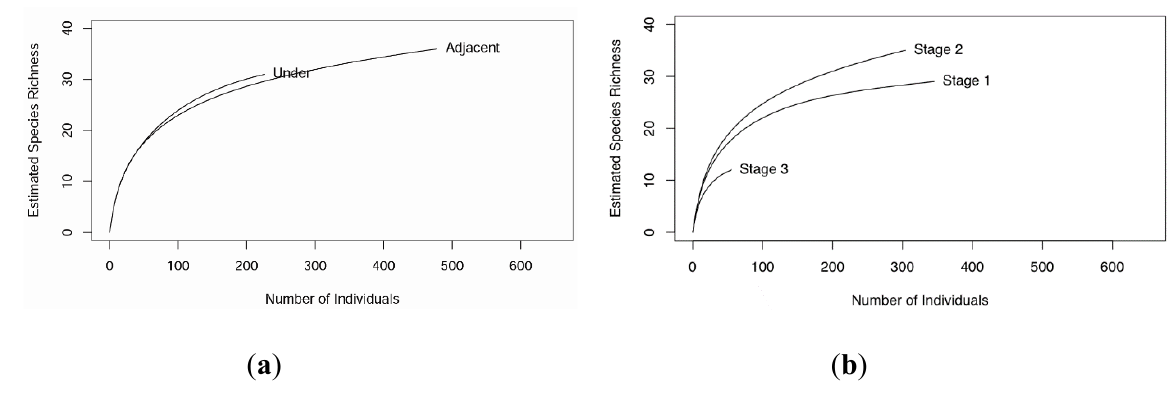
Figure 2. Rarefaction curves depicting estimated number of oribatid species per number of individuals sampled grouped among ( a ) both under and adjacent CWM positions and ( b ) among the three chronosequence stages (Stage 1: 60–95 years after fire. Stage 2: 133–373 years. Stage 3: 718 years). Standard error bars for these rarefaction curves overlap through most of the range and are omitted for